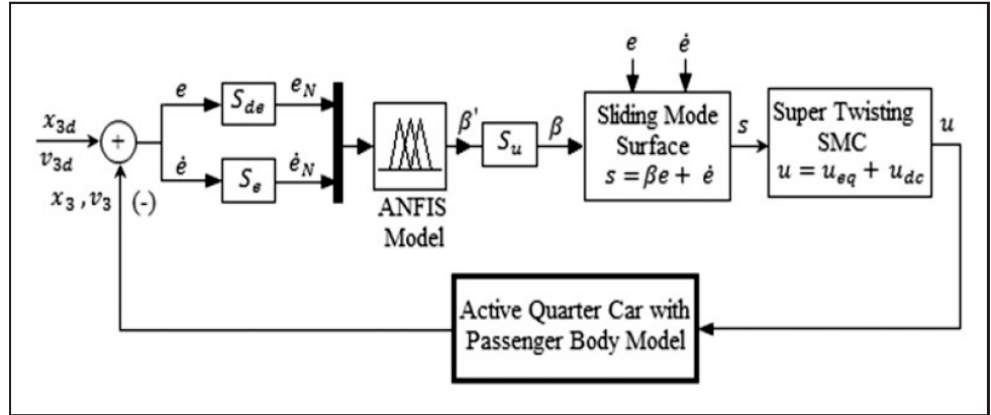
Figure 17. Hybrid structure of adaptive neuro fuzzy interference system (ANFIS) and super twisting sliding mode controller (ASTSMC) [63].